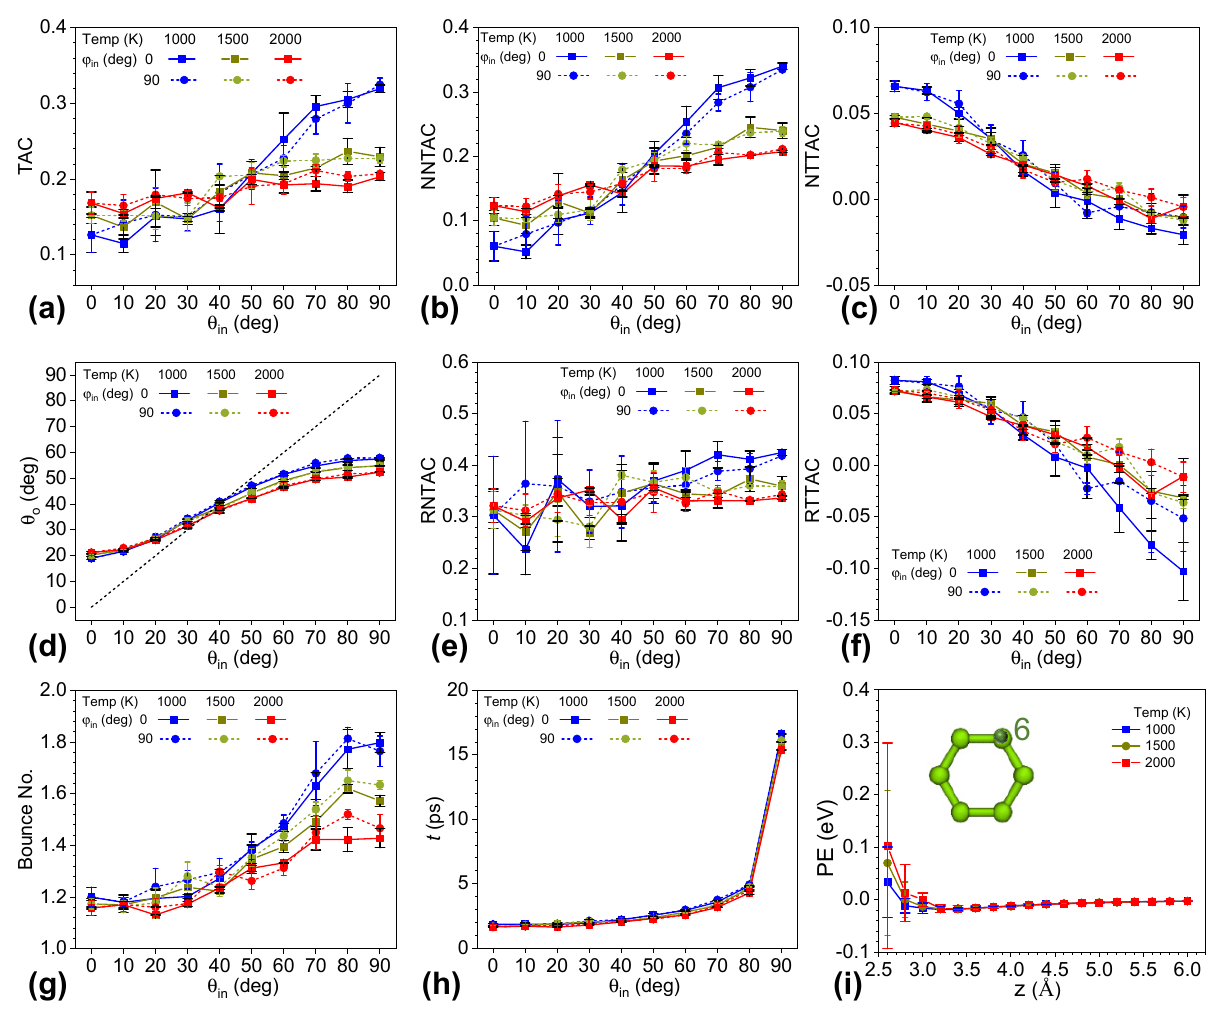
Figure 4. ( a ) TAC, ( b ) NNTAC, ( c ) NTTAC, ( d ) zenith angle of the scattered helium, ( e ) RNTAC, ( f ) RTTAC, ( g ) bounce number of helium, and ( h ) total collision time versus zenith angle of the incident helium with the azimuthal angle at 0° and 90°, respectively, and graphene temperatures of 1000 K, 1500 K, and 2000 K. The speed of helium corresponds to 500 K. ( i ) Potential energy of helium atom at the No. 6 in-plane location versus the distance of helium away from the graphene surface.